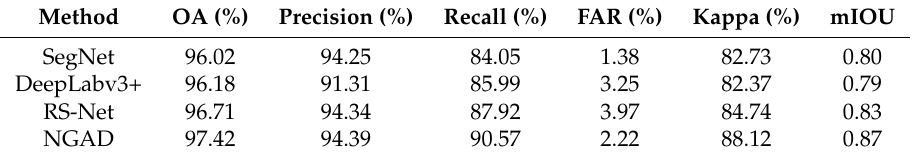
Table 3. Evaluation results with SegNet, DeepLabv3+, RS-Net, and NGAD models on the test